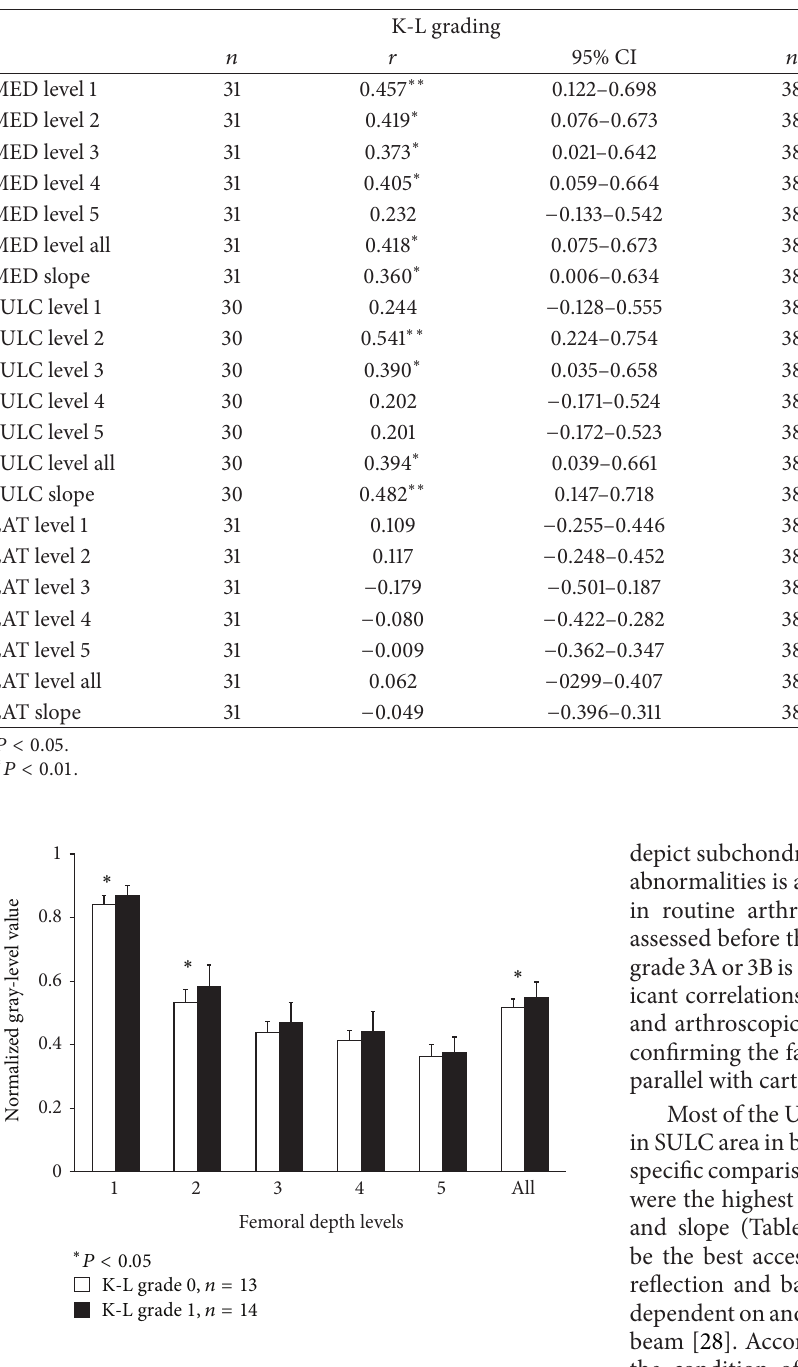
Table 3: Spearman’s rank correlations ( 𝑟 ) between ultrasound medial (MED), sulcus (SULC), and lateral (LAT) bone depth level intensities and intensity slopes and radiographic K-L grading or arthroscopic Noyes’ grading.